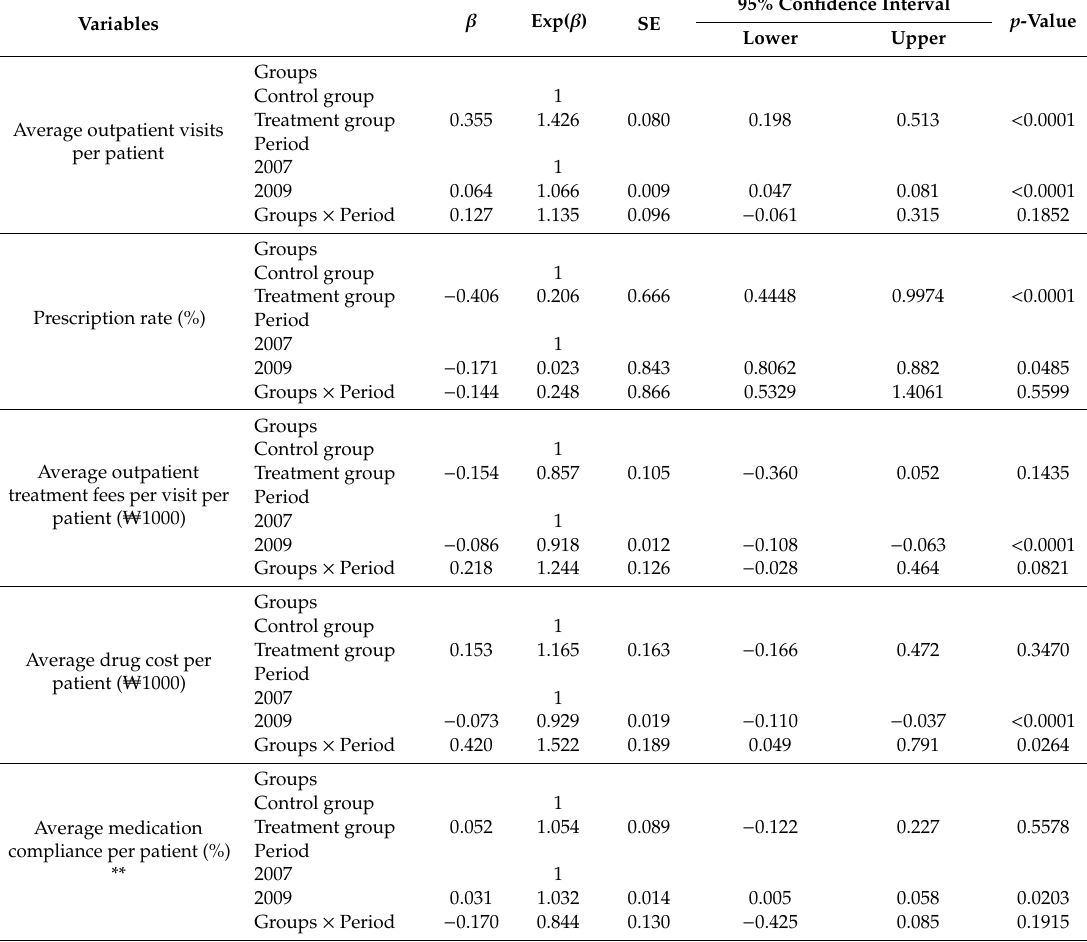
Table 3. E ff ects of the introduction of the DSP on the healthcare utilization outcome